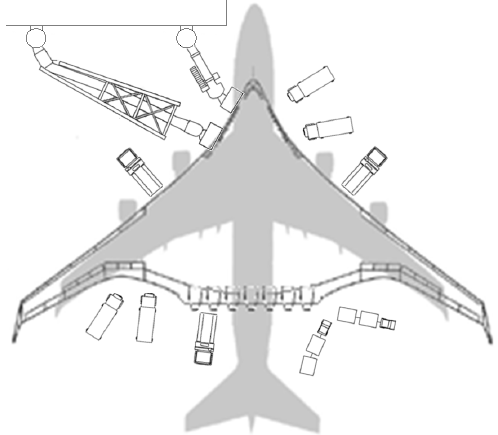
Figure 10. Turnaround gate layout. Adapted from